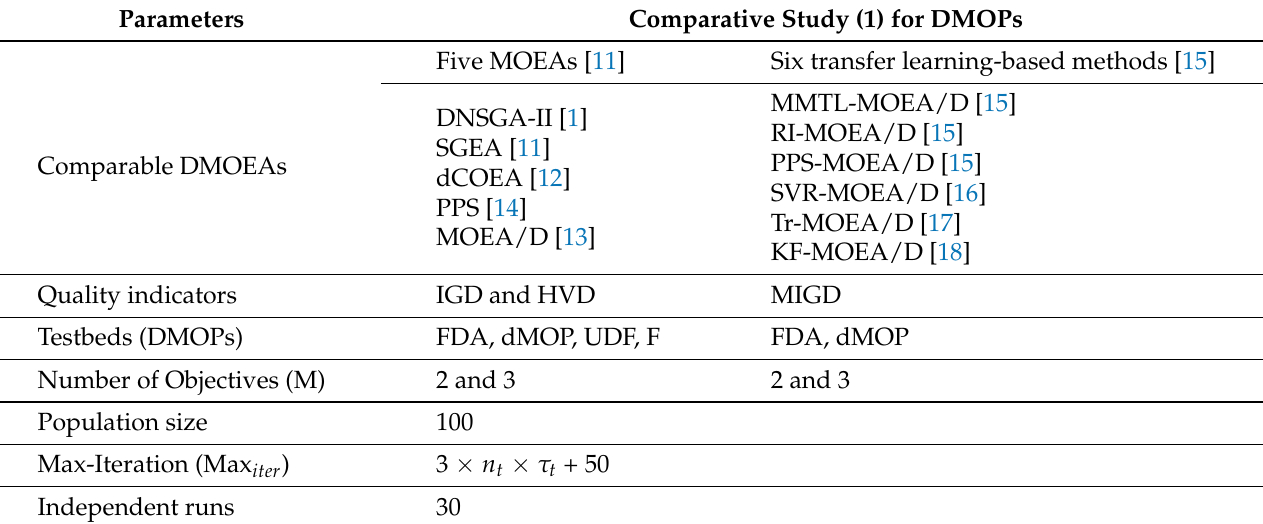
Table 3. Parameters Settings and DMOEAs Solvers used for the comparative study